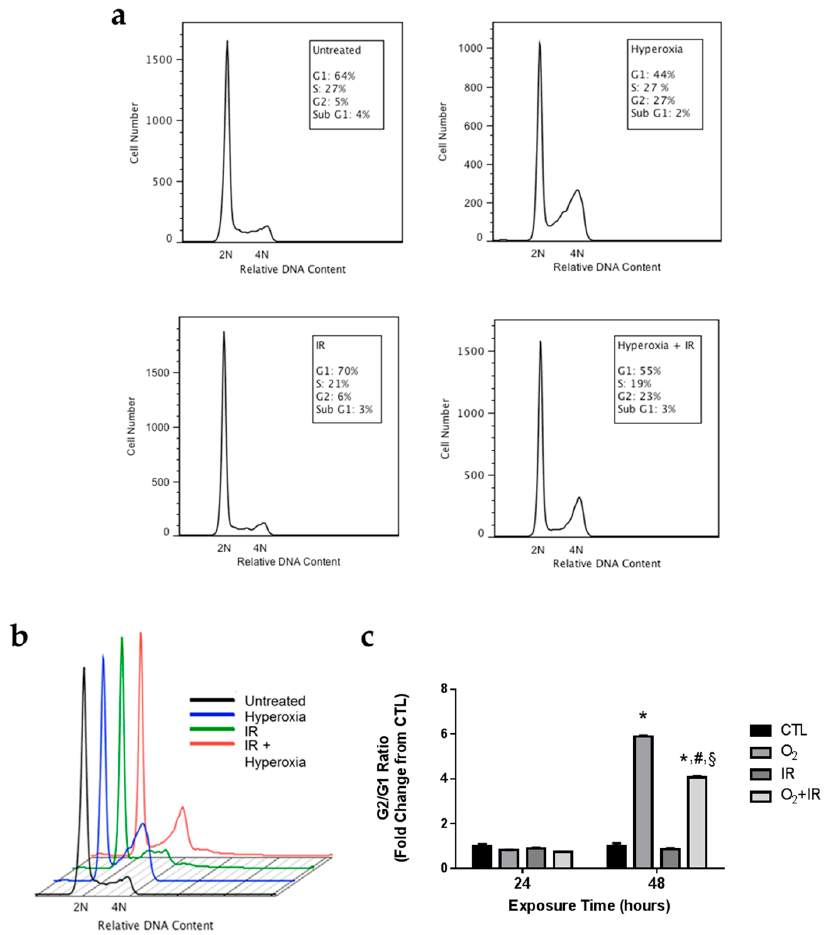
Figure 4. Hyperoxia and Combination Exposure Induces Cell Cycle Arrest. Non-tumorigenic murine alveolar type II epithelial cells (C10) were evaluated after 1 and 2 cycles of hyperoxia and radiation exposure and evaluated by flow cytometry for DNA content. ( a , b ) Cell cycle histograms display the DNA content (diploid or 2N; tetraploid or 4N) after 2 cycles (48 h) of exposure and ( c ) data are expressed as the ratio of G2 to G1. Data are presented as mean ± SEM. * p < 0.05 for each exposure condition as it compares with the unexposed control (CTL) in the same respective time-group; # p < 0.05 for significant differences between O 2 -alone compared to O 2 + IR; § p < 0.05 for significant differences between IR-alone compared to O 2 + IR.